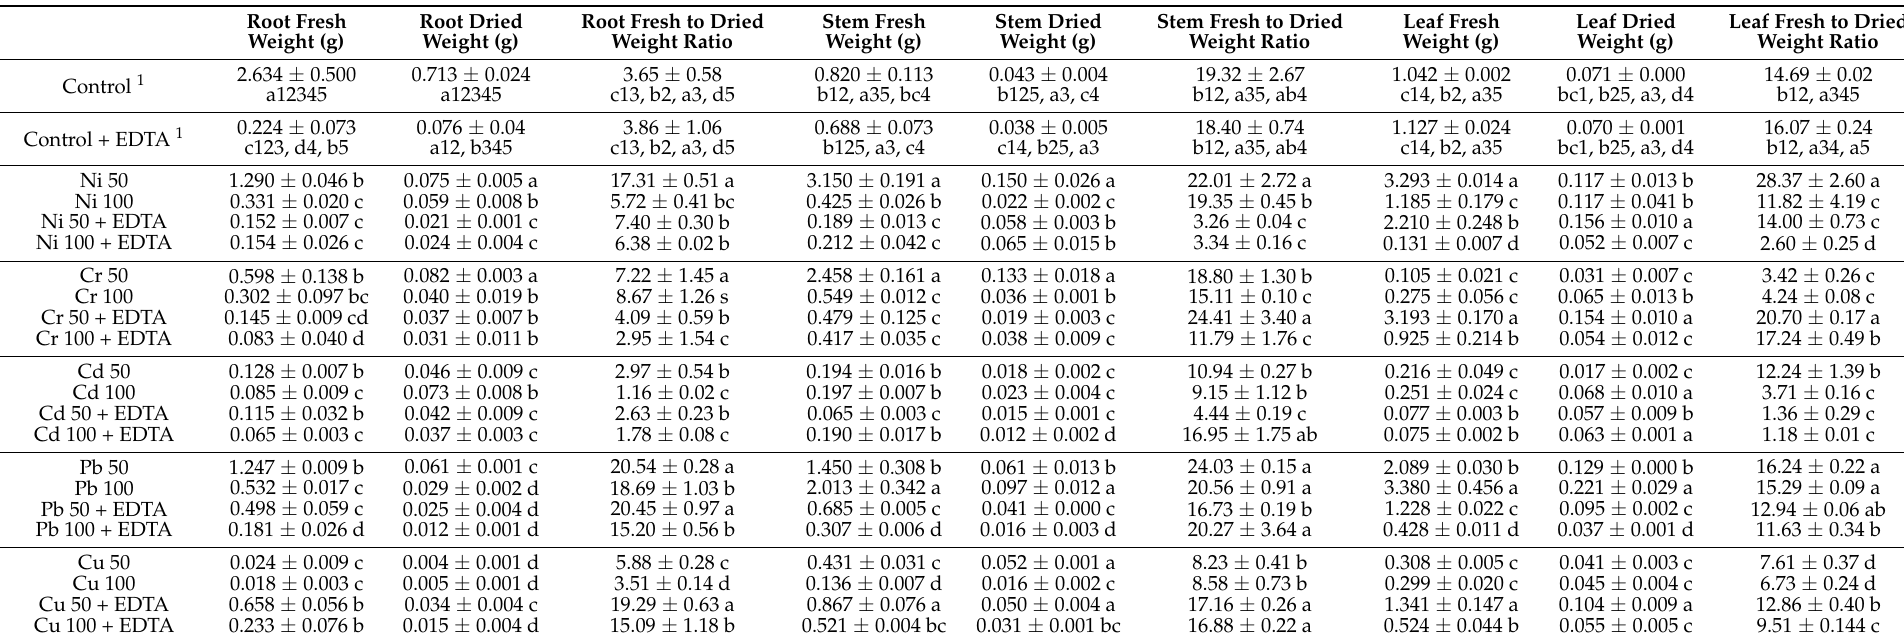
Table 3. Biomass production by Celosia argentea at different metal concentrations with and without